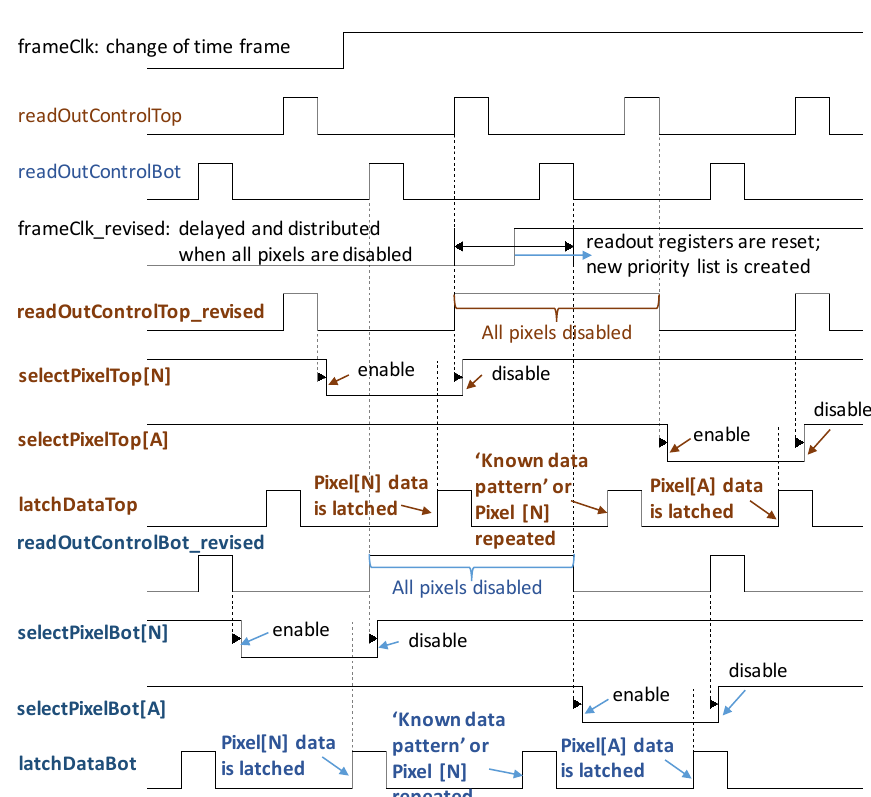
Figure 10. Modified control sequence to maintain data integrity at frame changes. When dynamically changing time frames, data loss and corruption are avoided by disabling all pixels while the frameClk is propagated across the ROIC. While the pixels are disabled a known data pattern or the previous pixel data is transmitted off-chip to identify the start of a frame.